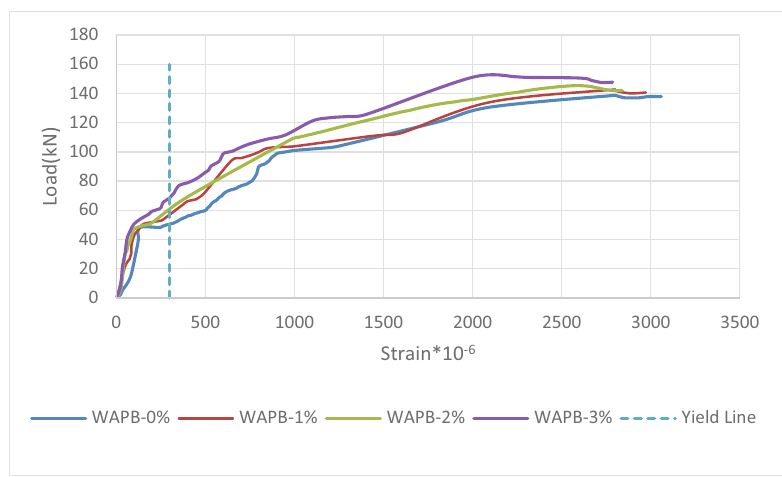
Figure 7: Load – strain curves for midspan fl exural steel reinforcement ( Sg. 2 ) .